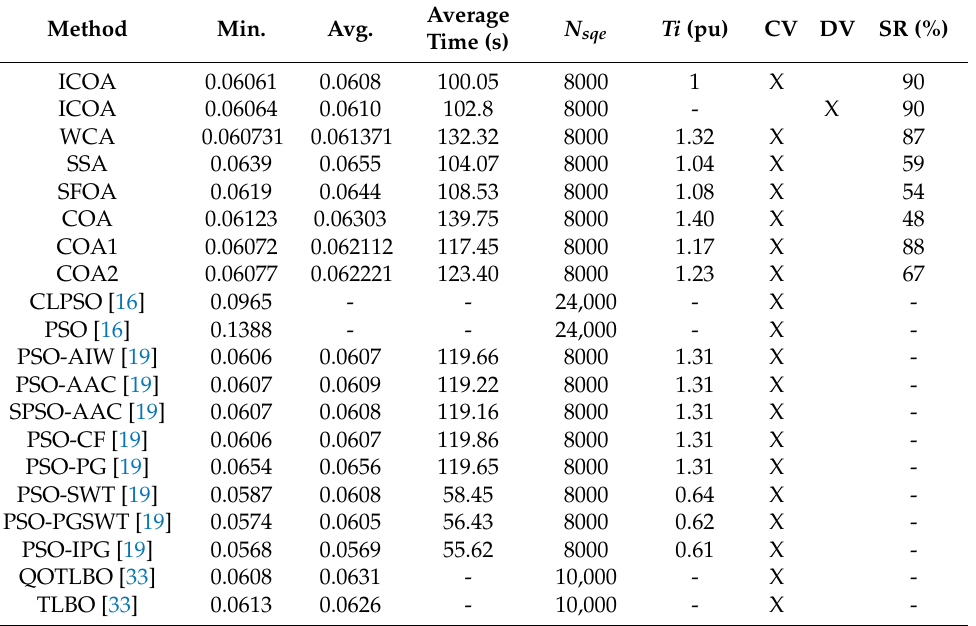
Table 13. Comparison of results obtained from the IEEE 118-bus system with voltage stabilization index optimization.